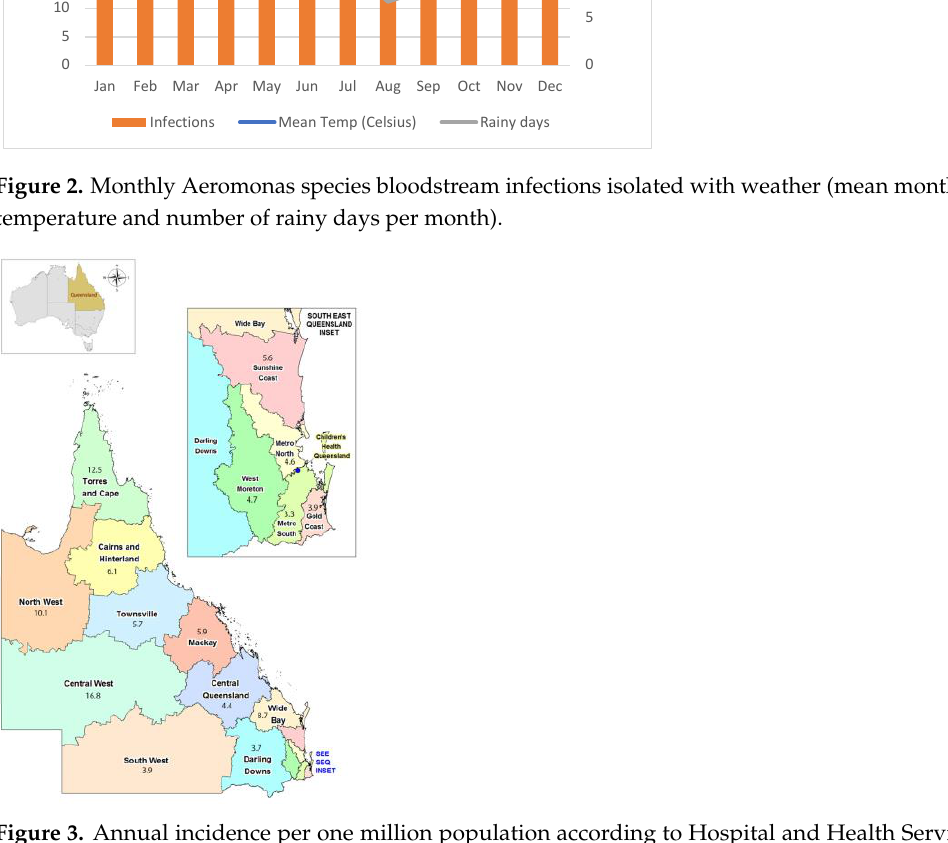
Figure 3. Annual incidence per one million population according to Hospital and Health Service, Queensland